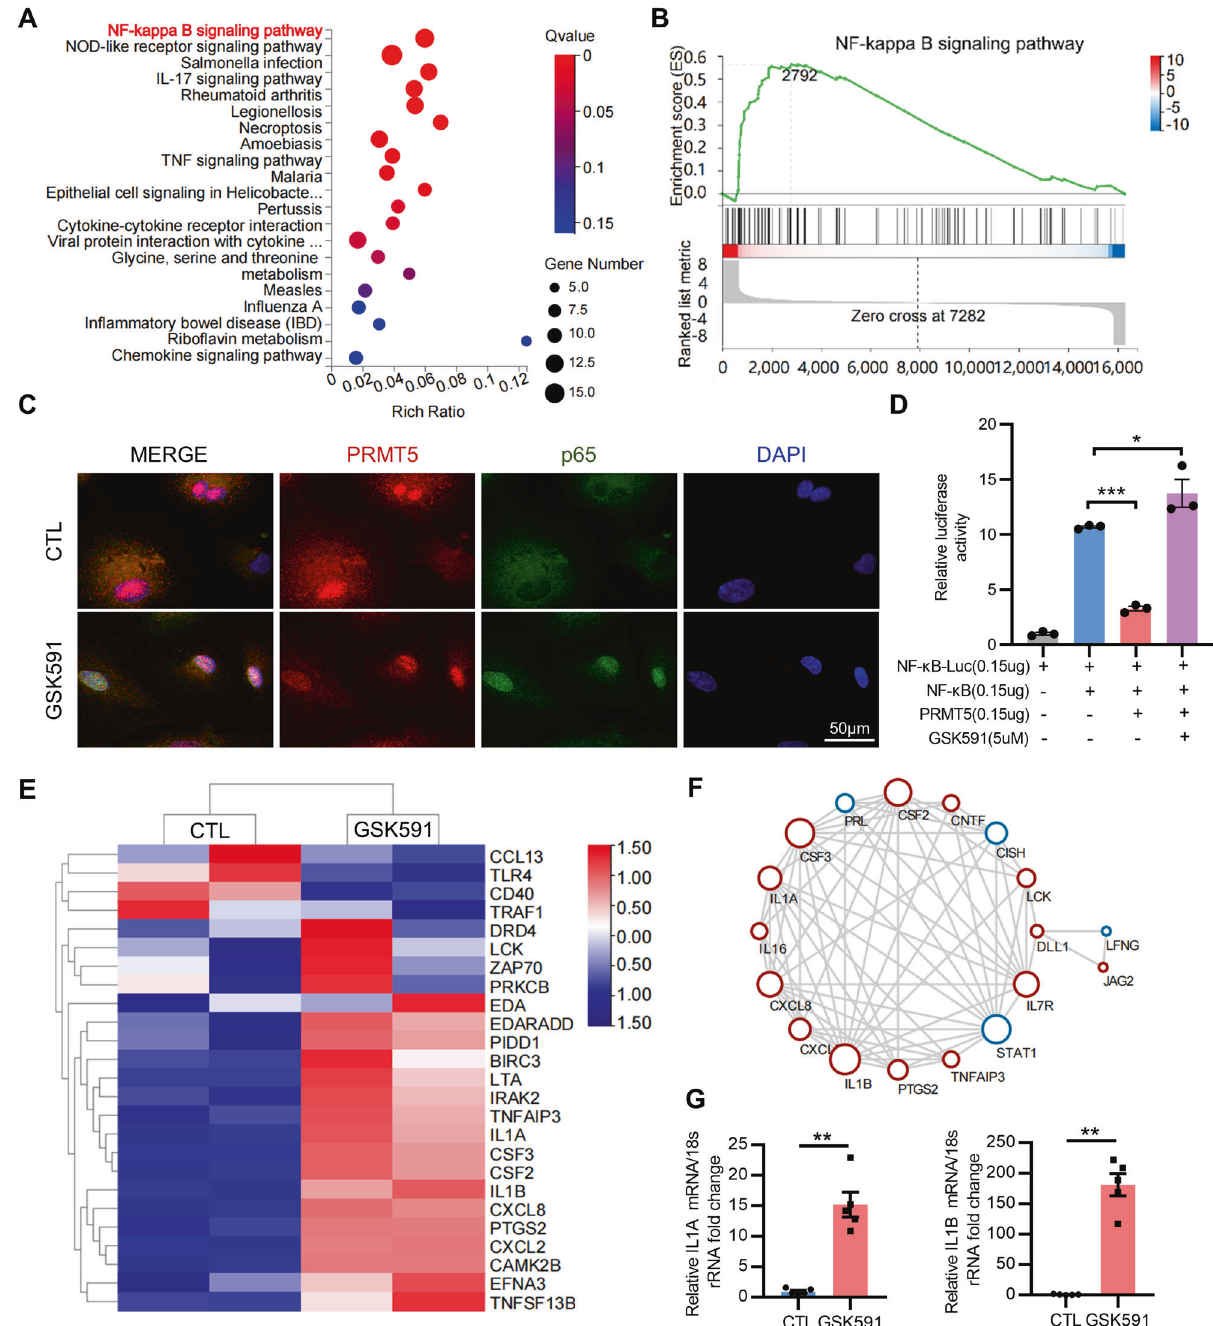
Fig. 6 Inhibiting PRMT5 activates the NF- κ B signaling pathway in human endometrial stromal cells. A The top 20 pathways enriched in differentially expressed genes between decidualized hEnSCs (dSC) and GSK591-treated decidualized hEnSCs (GSK591_dSC) in Kyoto Encyclopedia of Genes and Genomes analysis. B The Gene Set Enrichment Analysis revealed a signi fi cant enrichment of the NF- κ B signaling pathway in GSK591_dSC. C Analysis of the immuno fl uorescence staining of p65 and PRMT5 in hEnSCs treated with or without GSK591 after 72 h of treatment with 8Br-cAMP and MPA, scale bar = 50 µm. D Dual-luciferase assays of hEnSCs transfected with NF- κ B-luc and Rinella after treated with GSK591, or transfected with pCMV-NF- κ B or pCMV-PRMT5 for 48 h. E Heatmap of differentially expressed genes associated with the NF- κ B signaling pathway. E Protein – protein interaction network based on STRING analysis of the genes shown in D . F qRT – PCR analysis of IL1A and IL1B mRNA in GSK591_dSC and dSC. Means ± SEM, * P < 0.05, ** p < 0.01, *** P < 0.001, One-way ANOVA with Tukey ’ s multiple comparisons test in D , Student ’ s t -test in G